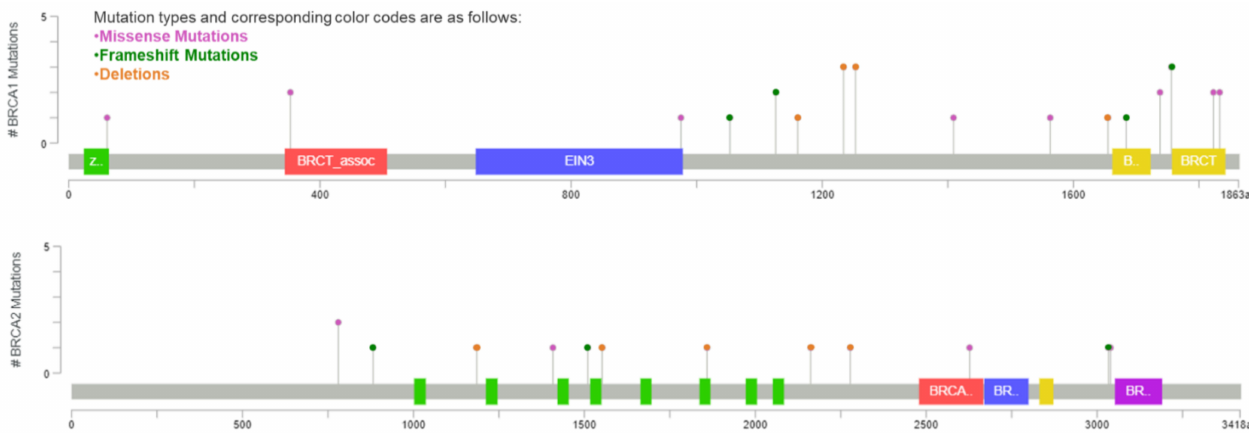
Figure 4. Germline mutations of BRCA1 and BRCA2 genes in the study cohort of ovarian cancer patients (whole exon deletions are not depicted). Mutation diagram circles are colored with respect to the corresponding mutation types. Abbreviations: zf-C3HC4: zinc finger, C3HC4 type (RING finger) (aa 24–64), BRCT_assoc: serine-rich domain associated with BRCT (aa 344–507), EIN3: ethylene insensitive 3 (aa 648–978), BRCT: BRCA1 C Terminus (BRCT) domain (aa